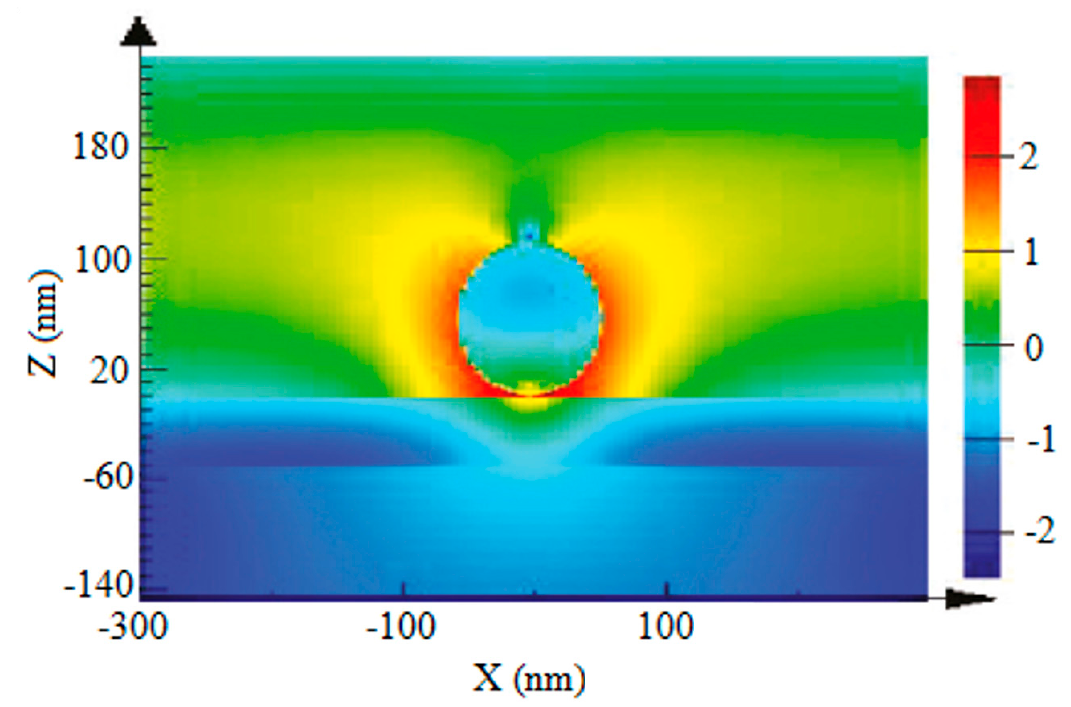
Figure 4. Ag NP–Au film at an incident wavelength of 632.8 nm [29].